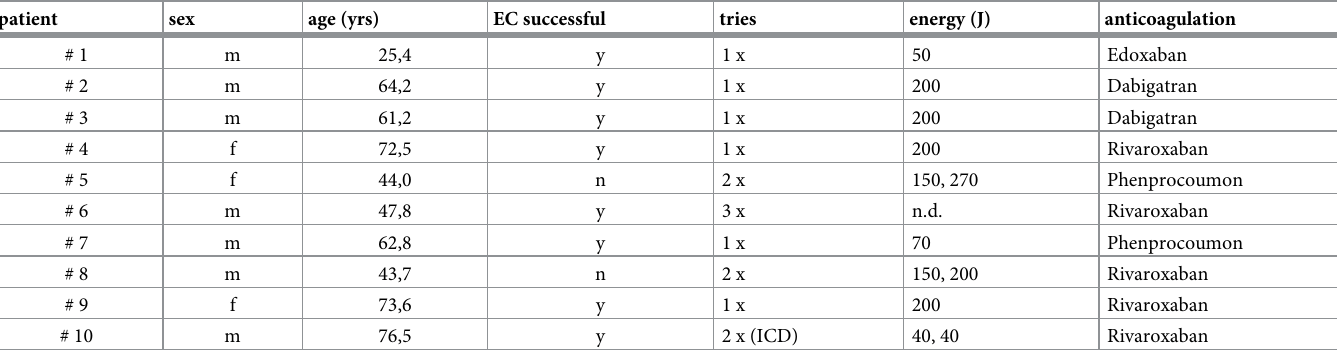
Table 1. Patient